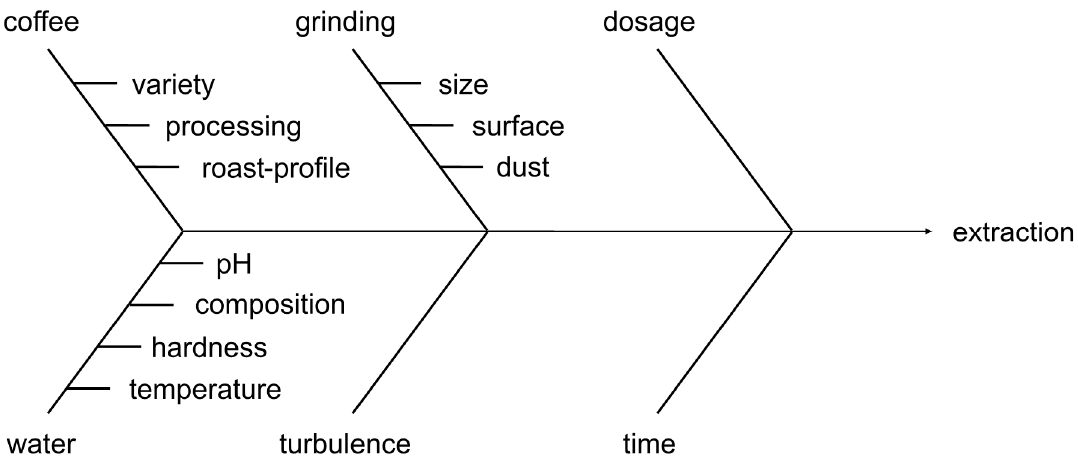
Figure 2. Ishikawa diagram of causal influences regarding cold brew coffee extraction.